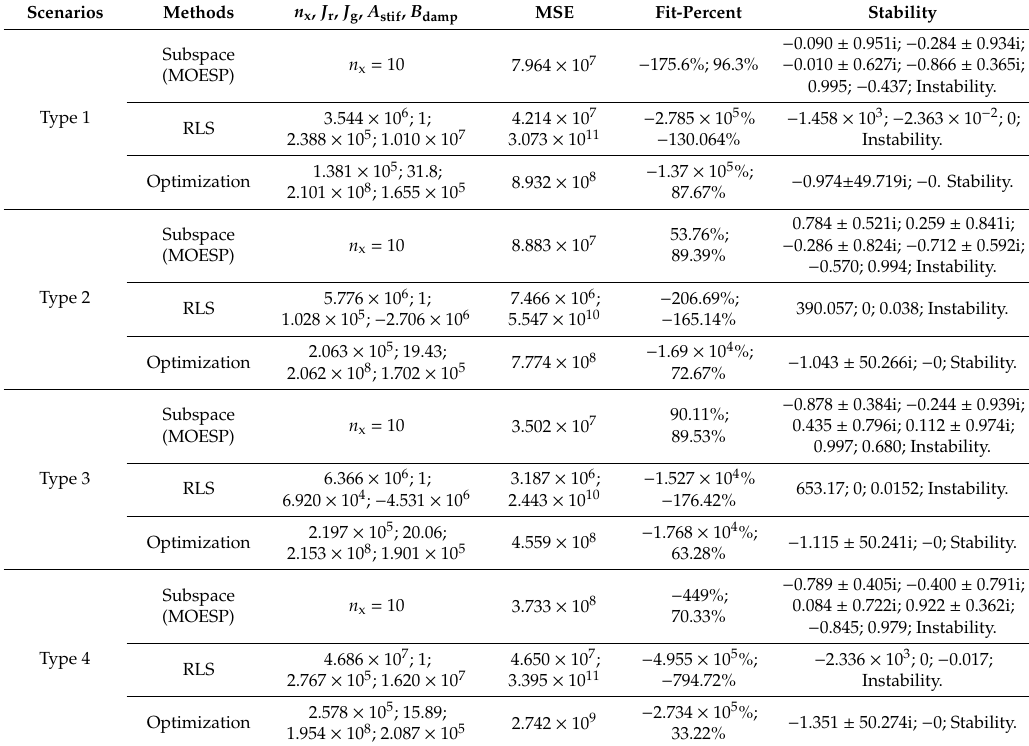
Table 5. Comparison of identification methods for two-mass